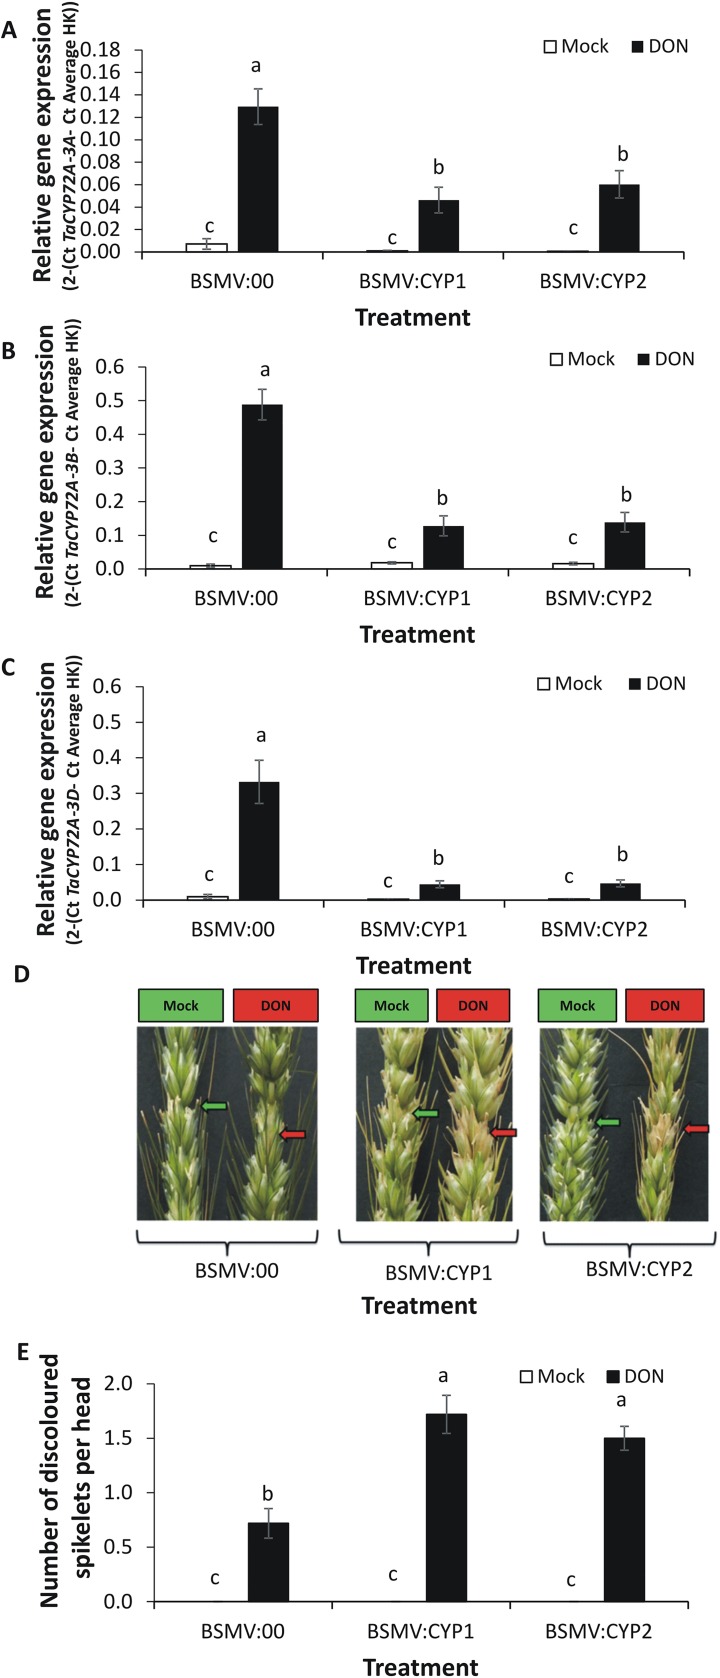
Virus-induced gene silencing (VIGS) of TaCYP72A in wheat heads.Plants of wheat cultivar CM82036 were subjected to VIGS using barley stripe mosaic virus (BSMV) constructs. Plants were treated with either BSMV:00 (empty vector) or BSMV:CYP1 or BSMV:CYP2 (constructs targeting TaCYP72A). Flag leaves were treated with the tripartite BSMV plasmids [28], prior to emergence of the first head, and subsequently emergent head treated with either 10 μl of 5 mg ml-1 DON or 0.02% Tween 20 (Mock treatment) at mid-anthesis. The spikelets just above the treated spikelets were collected for gene expression studies. Gene silencing in wheat spikelets was quantified by qRT-PCR analysis using primers specific to TaCYP72A-840 homeologs on chromosome (A) 3A, (B) 3B1/3B2 and (C) 3D; expression was calculated relative to the reference genes α-tubulin and GAPDH (2 - (Ct TaCYP72 –Ct Average HK)). (D) By 14 dpi DON-induced discolouration was more evident on gene-silenced as compared to on mock (virus) treated samples (arrow indicates spikelets treated with either Tween 20 or DON). (E) Quantification of the DON-induced discolouration of spikelets. Note that BSMV:00 treatment did not itself change the phenotype (as compared to non viral FES buffer treatment, for which the phenotypic results were previously shown [35]. Results (A), (B), (C) and (E) are the average of 32 heads per treatment (from two biological replicates). Error bars indicate SEM. Columns with the same letter are not significantly different (P<0.05).